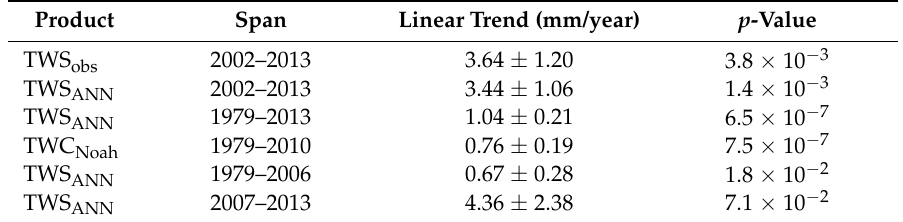
Table 5. Linear trends estimated from retrodicted GRACE and Noah series covering different time spans.